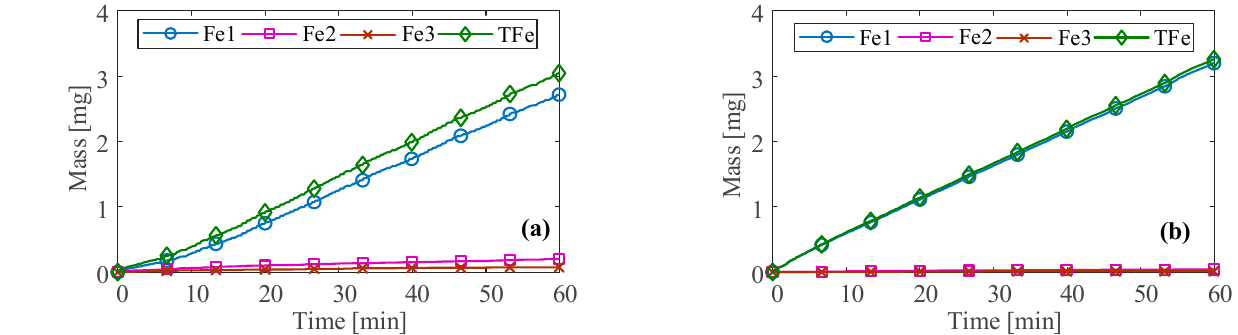
Figure 11. Ferrous particle accumulated mass at ( a ) normal and ( b ) unbalance.